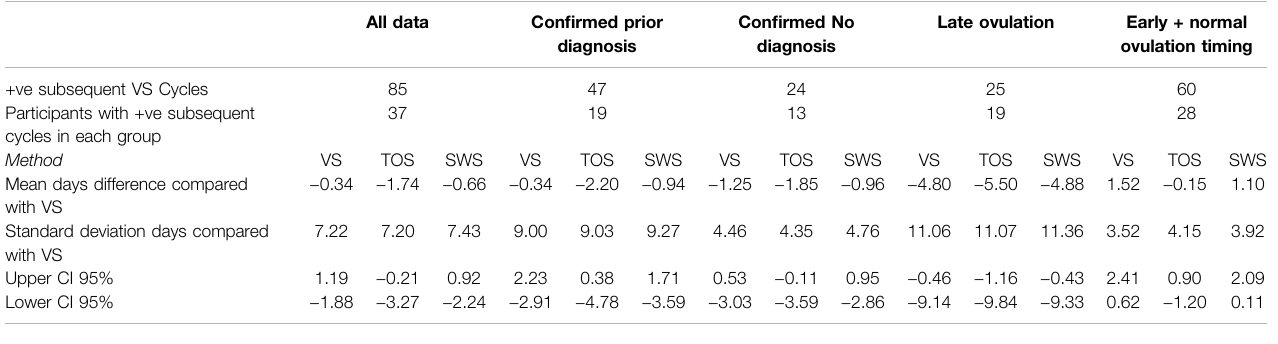
TABLE12| DaysdifferencebetweenVScon fi rmeddayofovulationforovulatorycyclescomparedwithpredicteddayofovulationbyVS,TOS,andSWSusingmediandayof ovulation prediction method for all data, and diagnosis and ovulation timing groups. All data